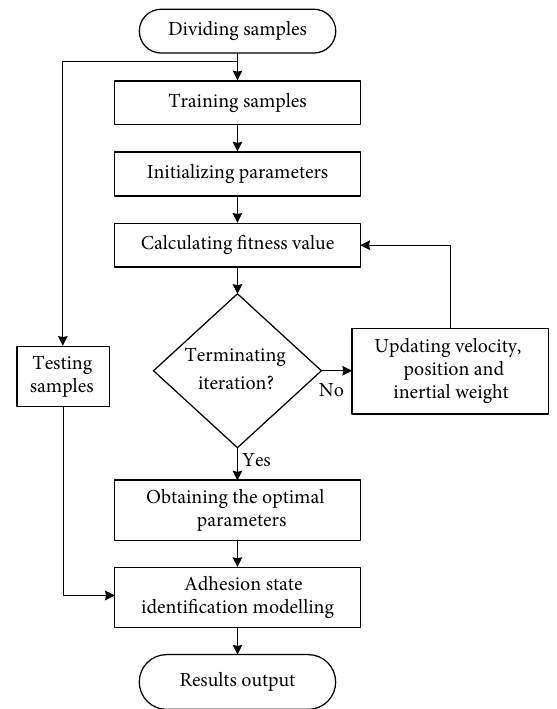
Figure 4: Flow chart of adhesion state identification model based on KELM and